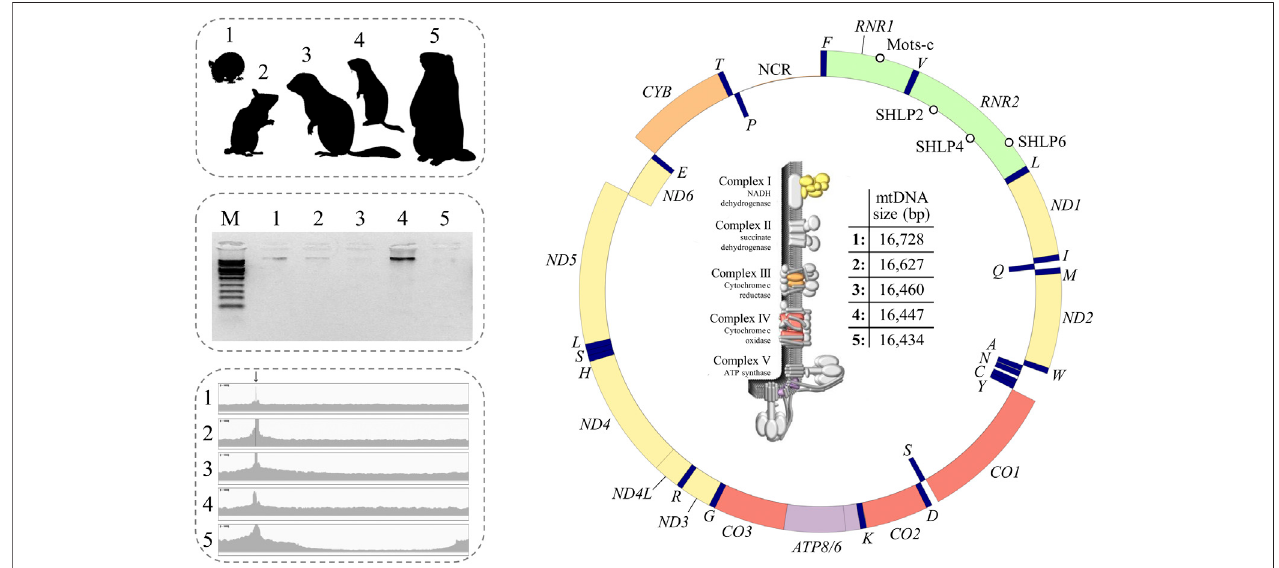
FIGURE 3 | Summary of this study including hibernator model species, electrophoretic separation of ampli fi cation products, sequence uniformity coverage plot, mitochondrial gene architecture, and a tabular view summarizing the slightly different mitogenome sizes (from left to right). The functional map of mtDNA depicts the similarity of gene architectures (identical gene order). The scheme of the circular mitogenome was constructed with the GenomeVx Web Browser ((Conant and Wolfe, 2008); http://wolfe.ucd.ie/GenomeVx/). The outside and inside of the ring indicate that the gene is encoded by the heavy and light chains of the mtDNA ring, respectively.Colourdepictsassignationofaprotein subunittoaparticularcomplexoftheelectrontransportchain(illustrationkindlyprovidedbyScottLujan(Lujanetal., 2020)). Note that complex II is exclusively composed of nuclear subunits. Empty circles: MDPs. The tRNAs were designated by single-letter amino acid abbreviation. Origins of heavy and light strand replications and 7S-DNA are not